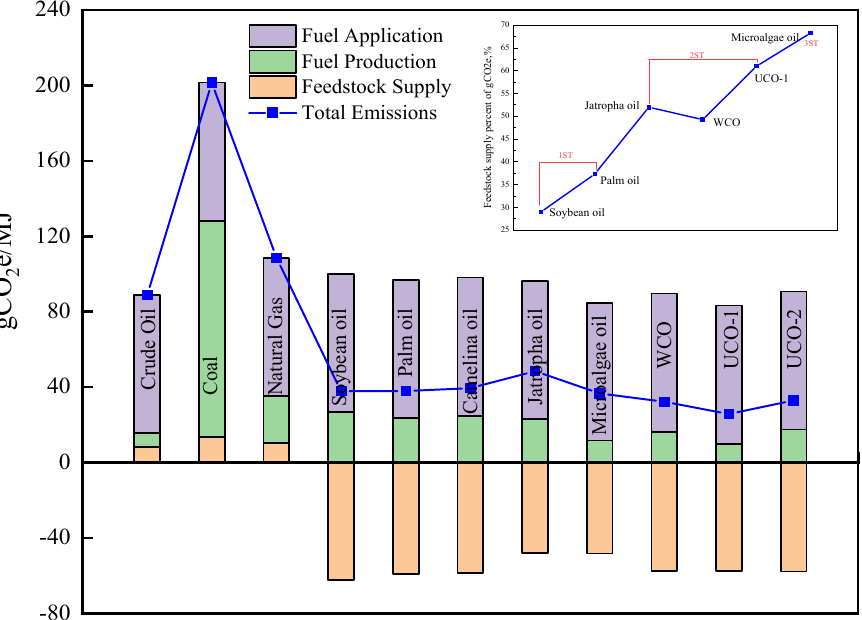
Figure 3. Bio-jet fuel life cycle greenhouse gas emissions of different